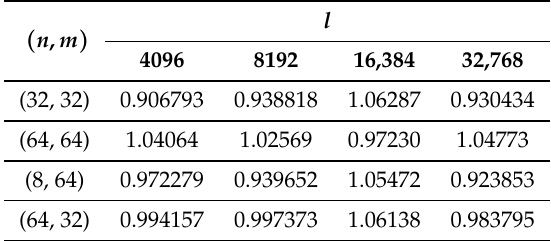
Table 5. Observed (cid:99) σ 2 ( Z T | H 0 ) values for each selected n , m , l value.